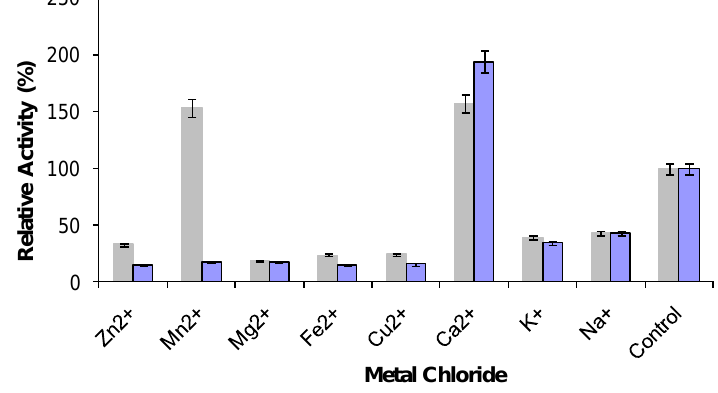
Figure 7. Effect of metal ion on purified recombinant L2 lipase. L2 lipase was preincubated at 65 °C for 30 min with different metal ions at 1 mM ( ) and 10 mM ( ) prior to lipase assay. The remaining activity was determined at 70 °C using olive oil emulsion (1:1, v/v in Glycine-NaOH buffer pH 9) and expressed as a percentage of the activity without the metal chlorides.